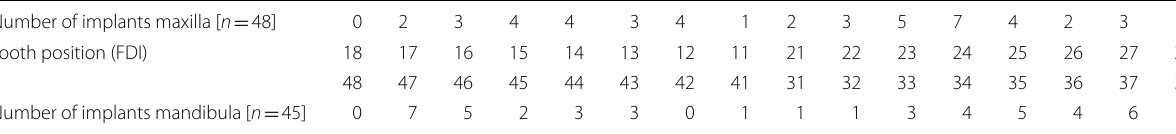
93] according to the FDI scheme =